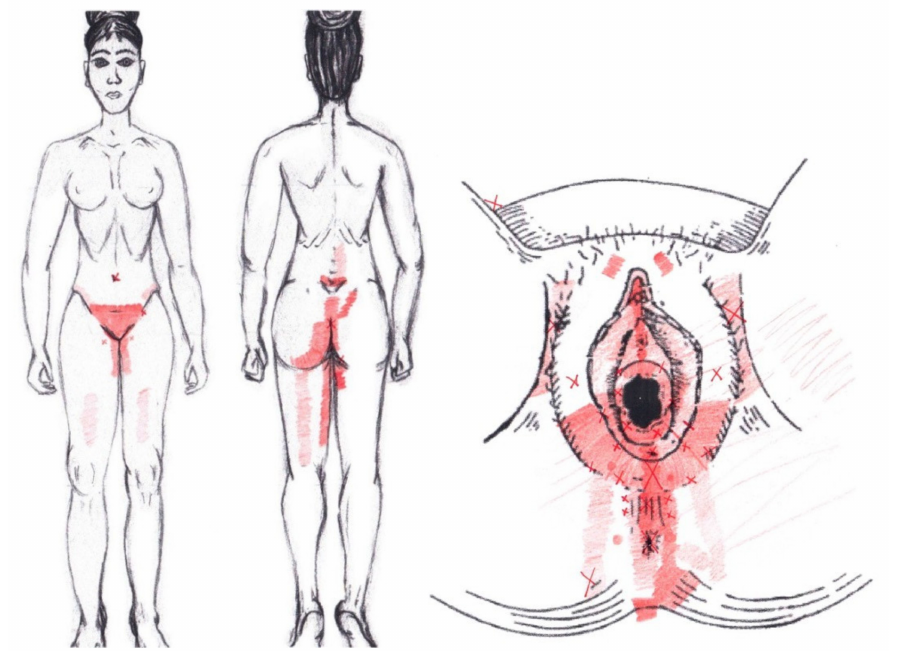
Figure 15. Graphical simulation of referred pain areas of the puborectalis